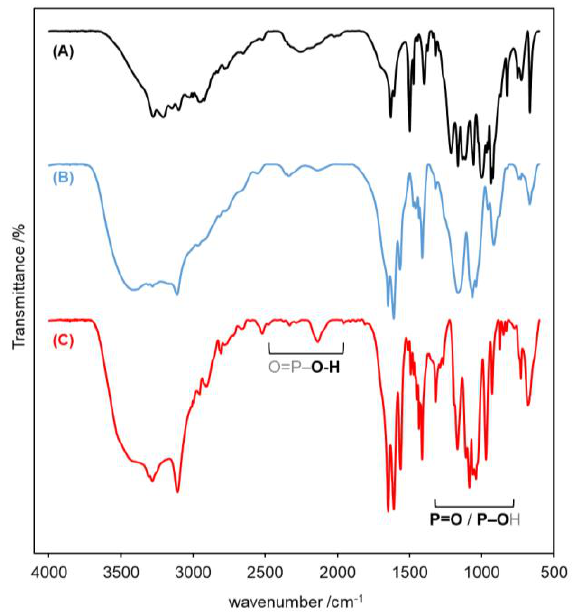
Figure 2. FTIR spectra of ( A ) ALN, ( B ) [TMGH][ALN] and ( C ) [TMGH] 2 [ALN]. Thermal Analysis of ALN–OSILs